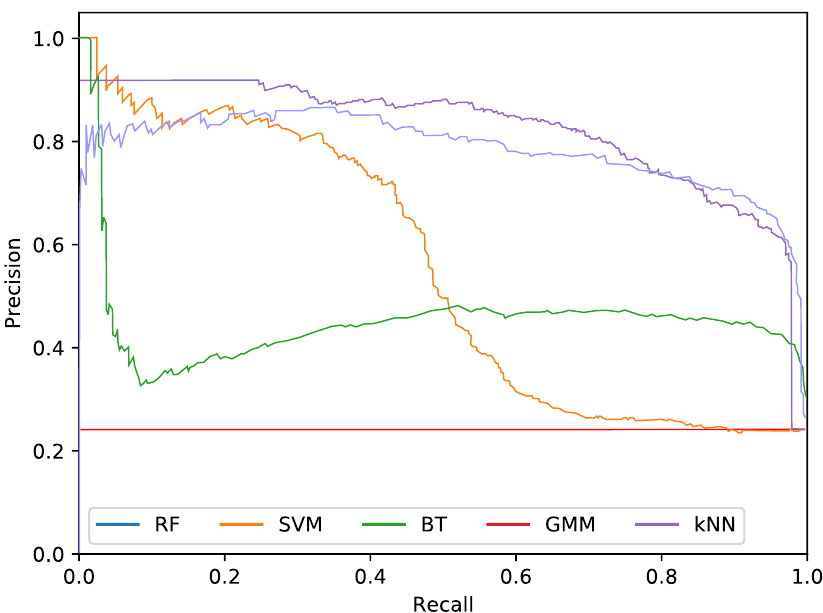
Figure 7. Precision-recall curve for the best performing classifiers using both colour and texture